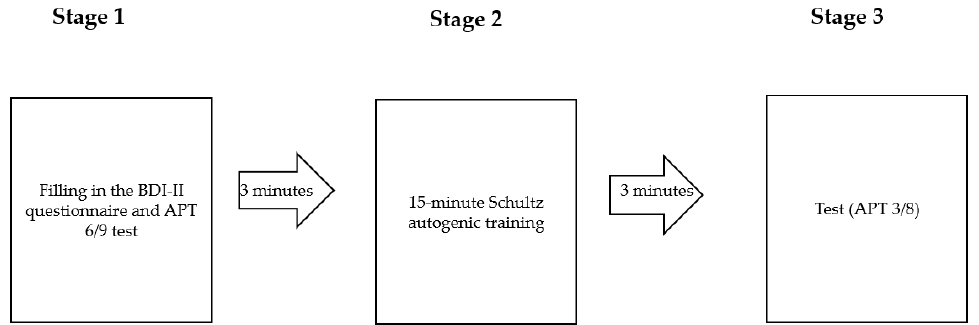
Figure 1. Study procedure. BDI-II—Beck Depression Inventory—Second Edition; APT 6/9—Attention and Perceptiveness Test, 6/9 version; APT 3/8—Attention and Perceptiveness Test, 3/8 version.